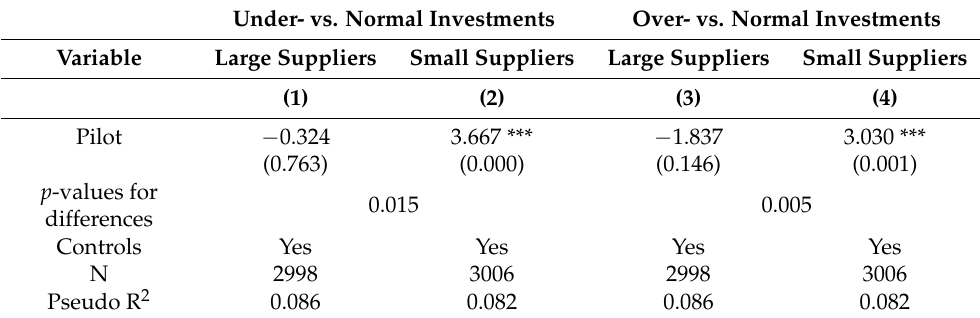
Table 4. Cross-sectional analyses: Relative size of suppliers. Under- vs. Normal Investments Over- vs. Normal